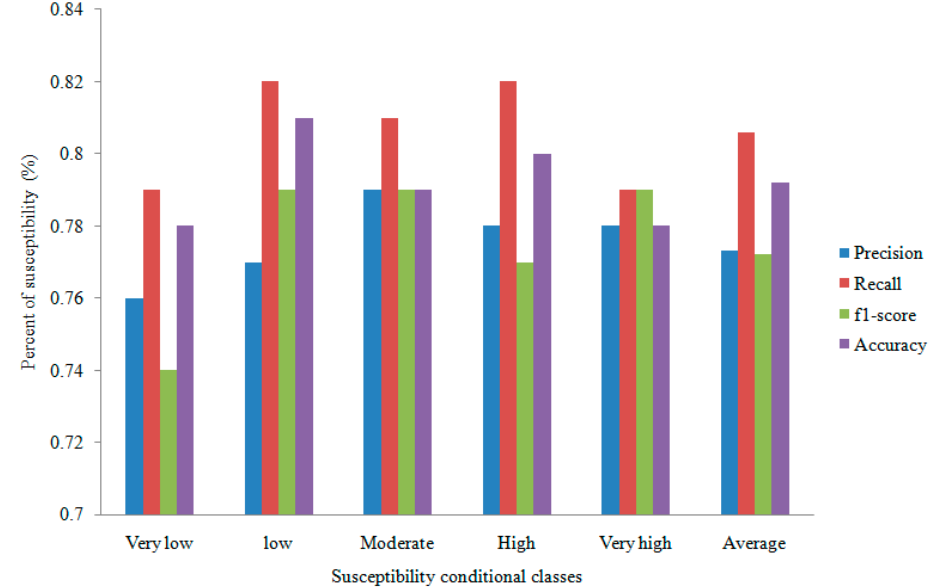
Figure 14. The confusion matrix of landslide susceptibility modelling performance.